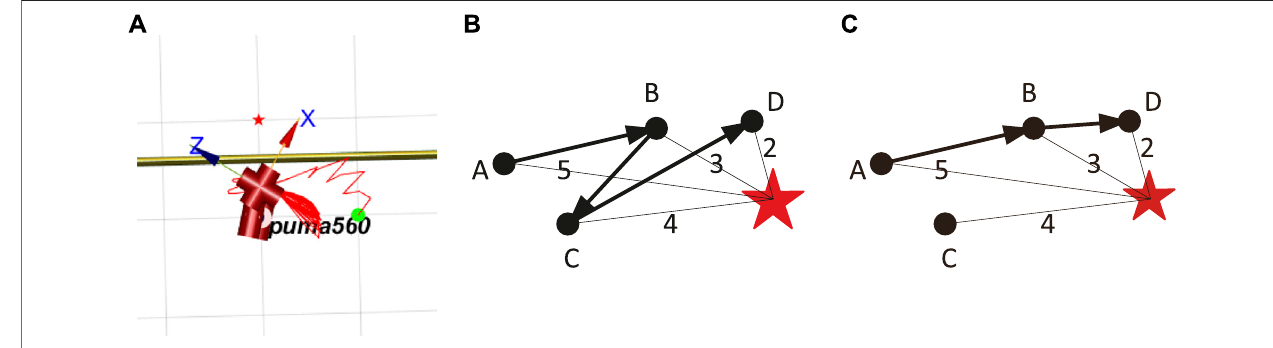
FIGURE 5 | Back-and-forth dilemma. (A) Back-and-forth dilemma of the manipulator. (B) Simulation 1st of back-and-forth dilemma. (C) Simulation 2nd of back- and-forth dilemma.